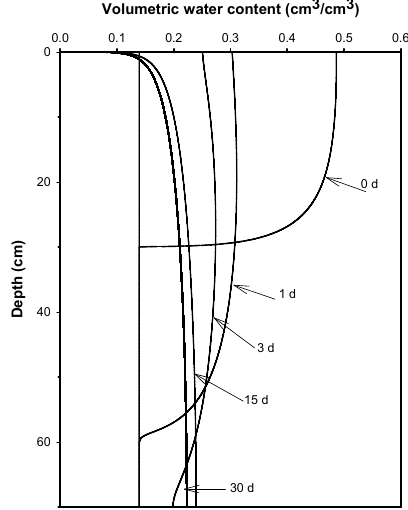
Figure 4. Water redistribution after one irrigation in the profile of the sandy loam soil in Montecillo, Mexico.